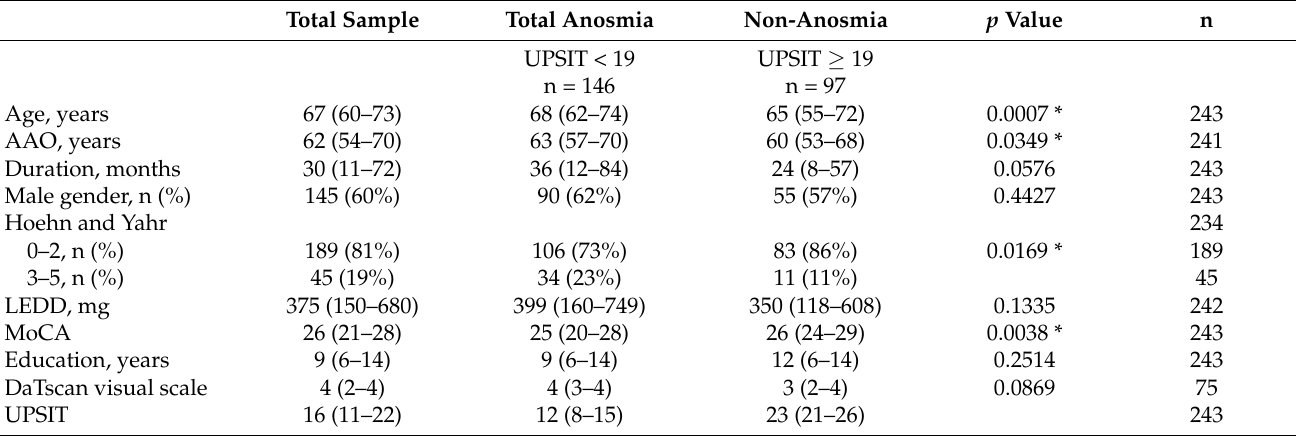
Table 1. Clinical features and comparison between the two